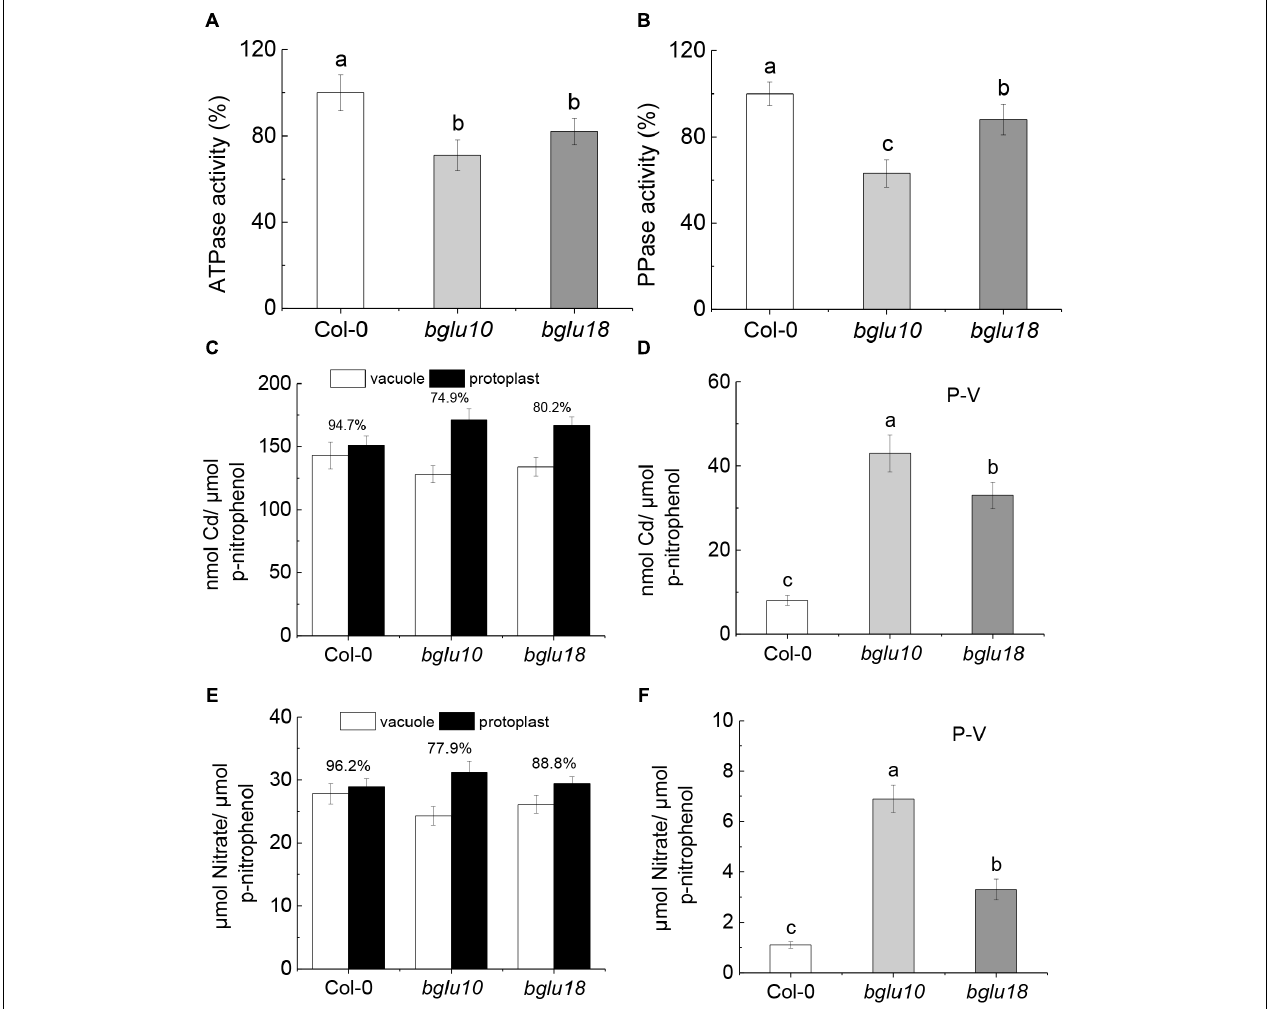
FIGURE 3 | Vacuolar proton pump activity in Arabidopsis wild-type (Col-0) and ABA mutants ( bglu10 and bglu18 ) root cells under Cd stress. (A) V-ATPase and (B) V-PPase activities in roots of Arabidopsis wild-type measured and ABA mutants under treatment with 20 µ mol L − 1 CdCl 2 . The proton pumps activity of the wild-type under Cd condition was set to 100%, and the specific activity of the root tonoplast proton pumps were expressed as percentage of that in the wild-type under Cd condition. (C) Cd 2 + distribution between the vacuole and protoplast in roots; values above the bars represent the percentage of vacuolar Cd 2 + relative to the total Cd 2 + in protoplasts; (D) roots total Cd 2 + accumulated in cytoplasm (P-V) calculated as total Cd 2 + in protoplast – total Cd 2 + in vacuole. (E) NO − 3 distribution between the vacuole and protoplast in roots; values above the bars represent the percentage of vacuolar NO − 3 relative to the total NO − 3 in protoplasts; (F) roots total NO − 3 accumulated in cytoplasm (P-V) calculated as total NO − 3 in protoplast – total NO − 3 in vacuole. Data represent means ± SE ( n = 4). Bars with the same letter indicate no significant difference at P < 0.05 level by the method of